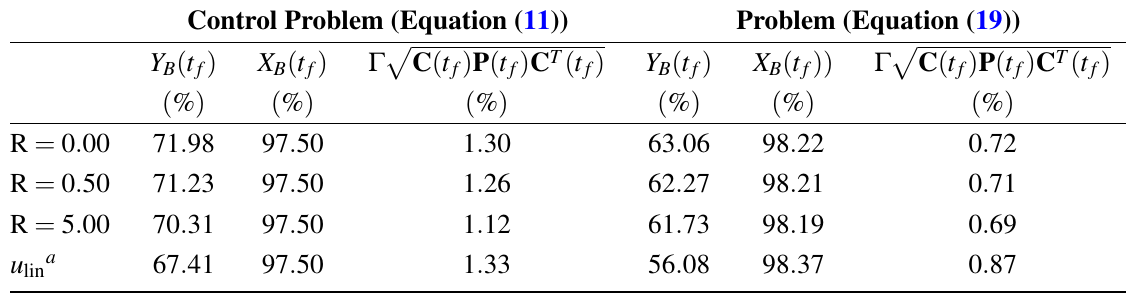
Solutions to the Open-loop Optimal Solutions to the Robust Counterpart Control Problem (Equation (11)) Problem (Equation (19))